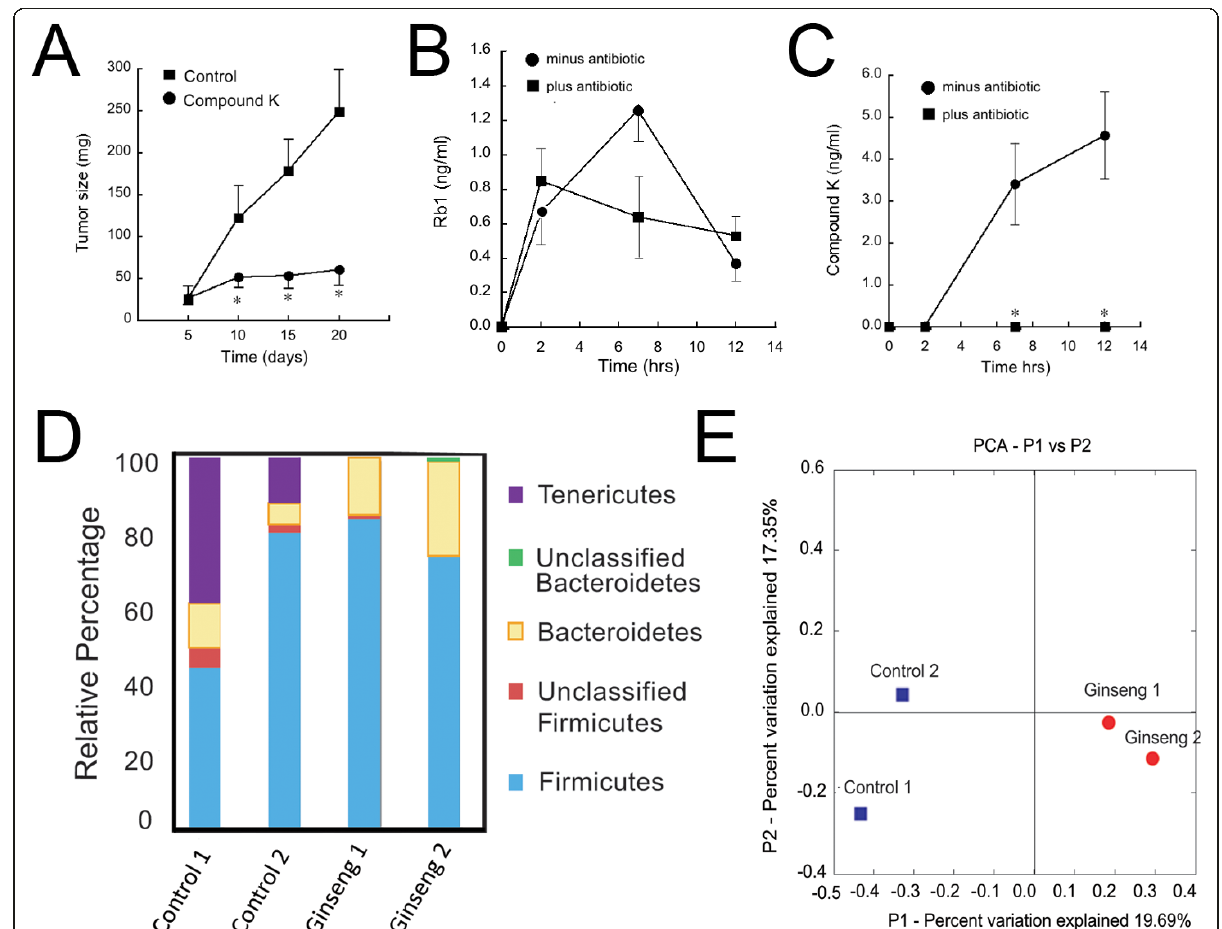
Figure 4 Dietary ginseng alters the composition of the bacterial flora while intraperitoneal compound K inhibits colon cancer xenograft growth . A . Compound K inhibits colon cancer growth in tumor xenograft. HCT116 cells (5*10^6 cells) were implanted into flanks of nu/nu mice and allowed to grow for 5 days. Mice were then treated with compound K (30 mg/kg-body wt or DMSO (compound K vehicle). At indicated times tumor size was estimated by linear dimensions [volume = 1/2 × length × (width) 2 ] and expressed in mg (*p < 0.05 compared to control, n = 5 mice in each group). B . Rb1 absorption. Mice were un-treated or treated with metronidazole in the drinking water. After 5 days animals were gavaged with 500 mg ginseng extract/kg body wt. At indicated times after ginseng gavage, plasma levels of ginsenoside Rb1 were measured by UPLC-mass-spectrometry/TOF. C . Compound K absorption. Mice were treated as described in 4B and Compound K (C-K) measured by UPLC-mass-spectrometry/TOF. Data were expressed as means ± SEM depicted by vertical bars (p < 0.05 compared to mice